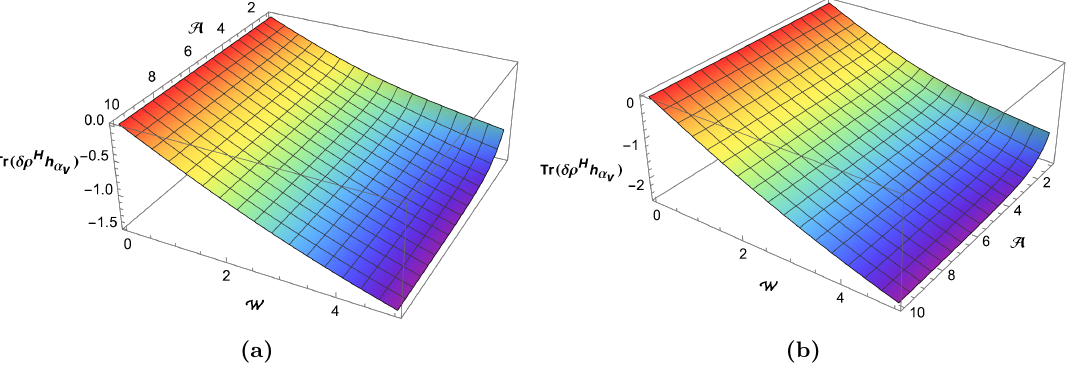
Figure 1. Initial state | s i for parallel motion: plots (a) and (b) show trace corresponding to work done by the system, Tr( δρ H h ( A ) and dimensionless energy gap ( W ) of the composite system for α